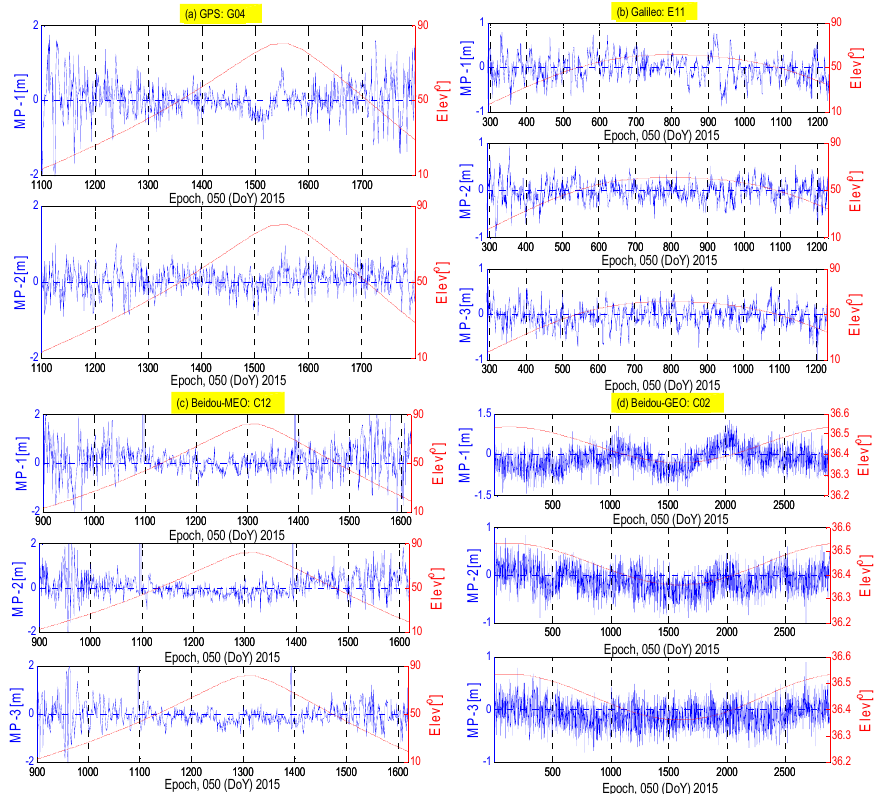
Figure 1. The multipath estimations ( blue ) and satellite elevation ( red ) for ( a ) GPS satellite G04; ( b ) Galileo satellite E11; ( c ) Beidou MEO C12 and ( d ) GEO C02 at station CUT0. Each row represents the multipath estimations for different frequencies.